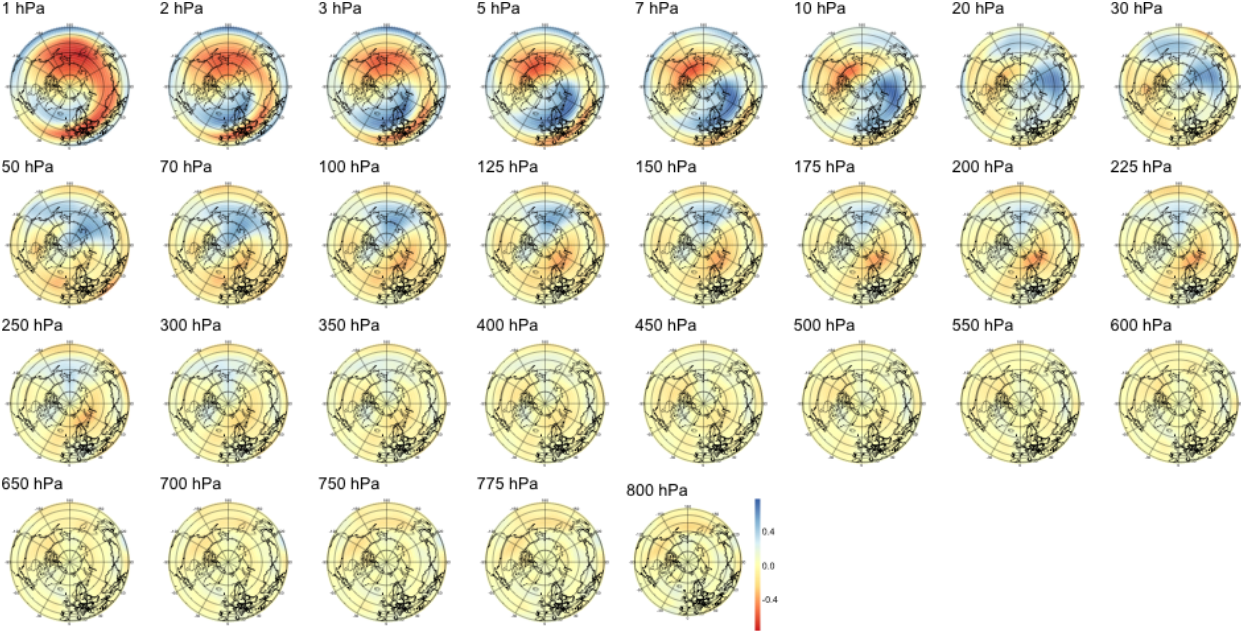
Figure B3. Pattern of PV anomalies maximizing correlation with the SSW index at a lead time of 30d.